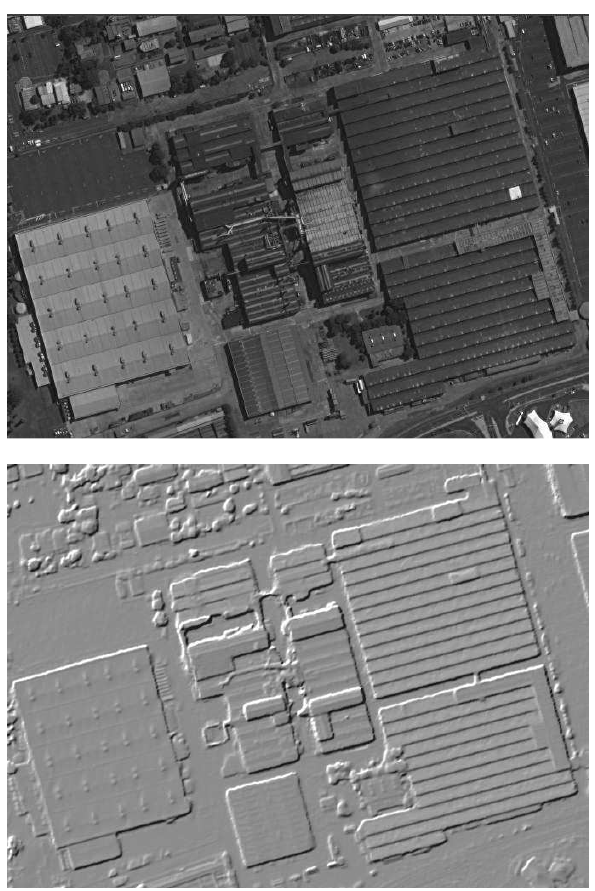
Figure 7 Melbourne DEM (detail) images sequences is the reduction of occlusions